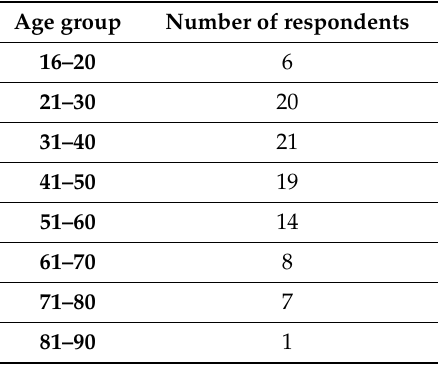
Table 1. Age distribution of the